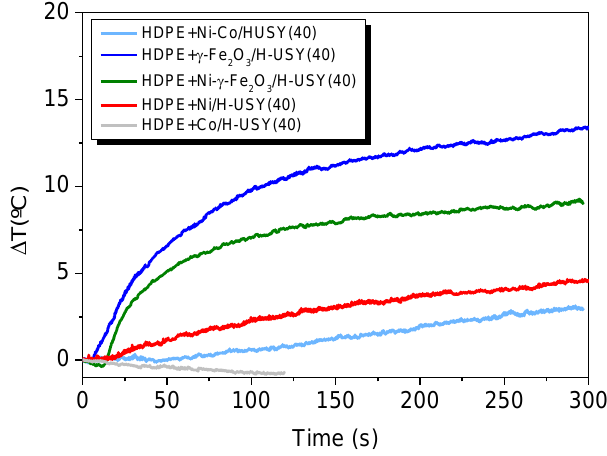
Figure 6. Temperature increment curves (526 kHz) for HDPE films containing H-USY(40) impreg- nated with: γ -Fe 2 O 3 (Dark blue), Ni– γ -Fe 2 O 3 (Green), Ni (Red), Ni–Co mixture (Light Blue) and Co (Grey) over time.